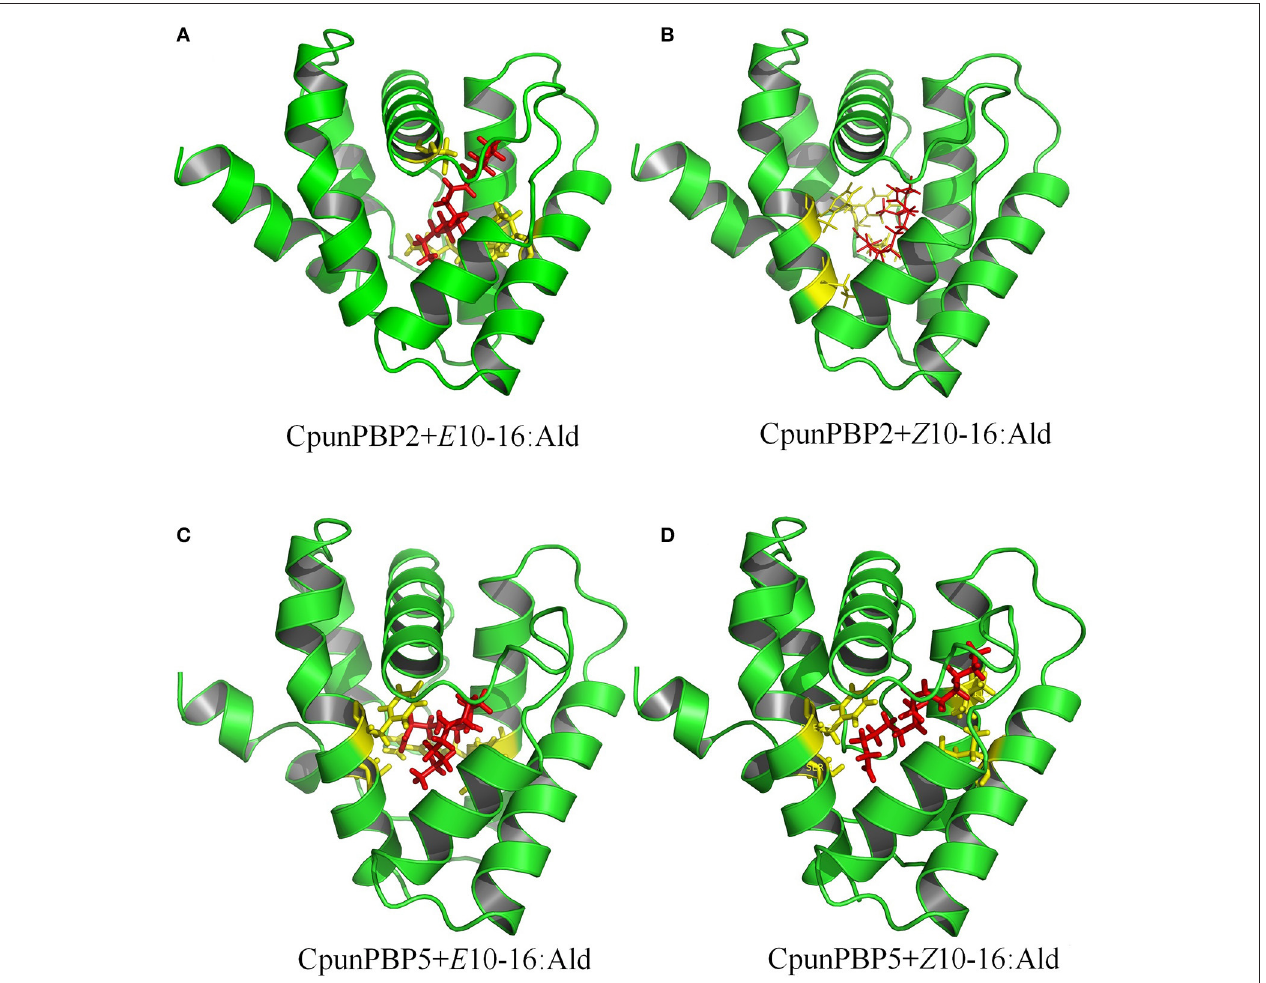
FIGURE 5 | Docking of CpunPBP2 and CpunPBP5 with pheromone compounds. (A) Molecular docking of predicted CpunPBP2 model with E 10-16:Ald. (B) Molecular docking of predicted CpunPBP2 model with Z 10-16:Ald. (C) Molecular docking of predicted CpunPBP5 model with E 10-16:Ald. (D) Molecular docking of predicted CpunPBP5 model with Z